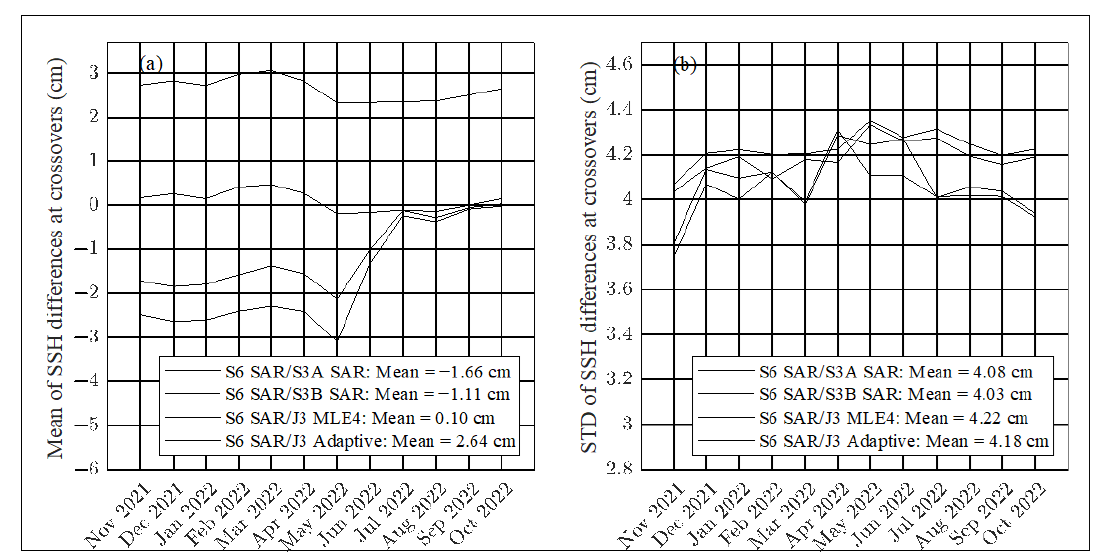
Figure 6. Month per month monitoring of the ( a ) mean and ( b ) STD of the SSH differences computed at Sentinel-6 (SARM) and Sentinel-3A/B and Jason-3 crossovers.